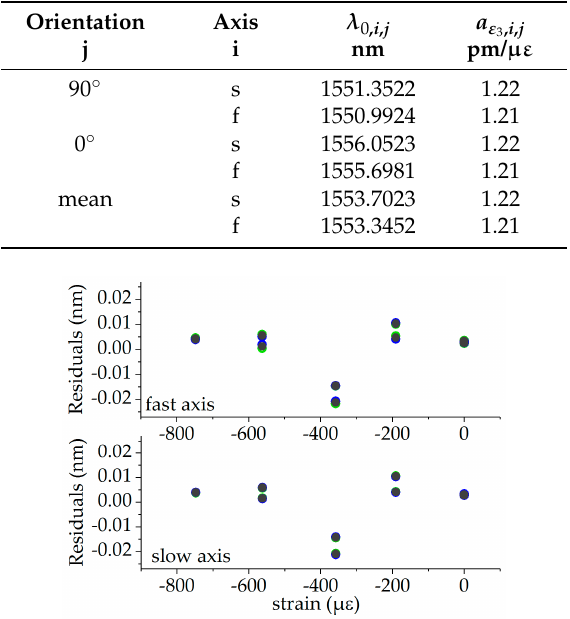
Figure 11. Residuals of the strain calibration: FBG in the 0°-orientation in green, FBG in the 90°-orientation in blue, and mean values in grey. Table 3. Fitting parameters of the strain calibration of the PM tandem.